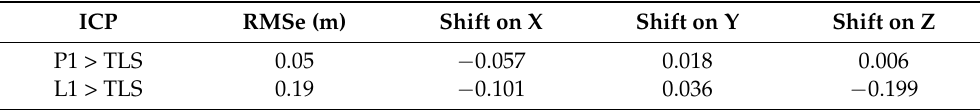
Table 10. ICP registration and alignment